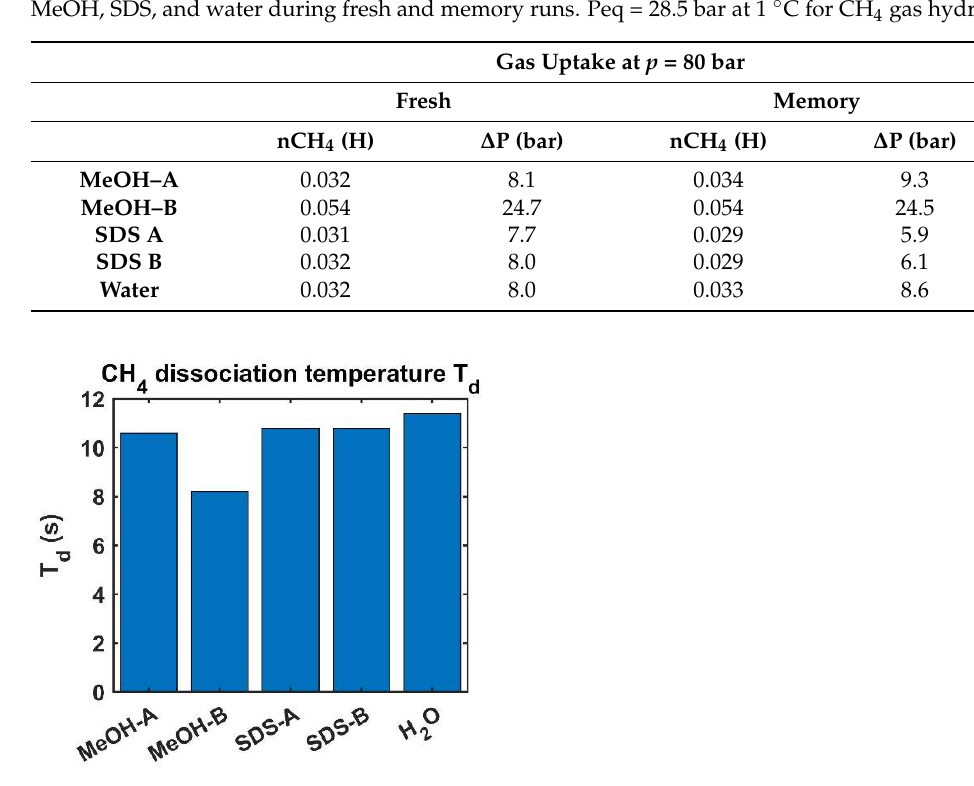
Figure 4. T d of different chemicals during SCR using rocking cell setup.